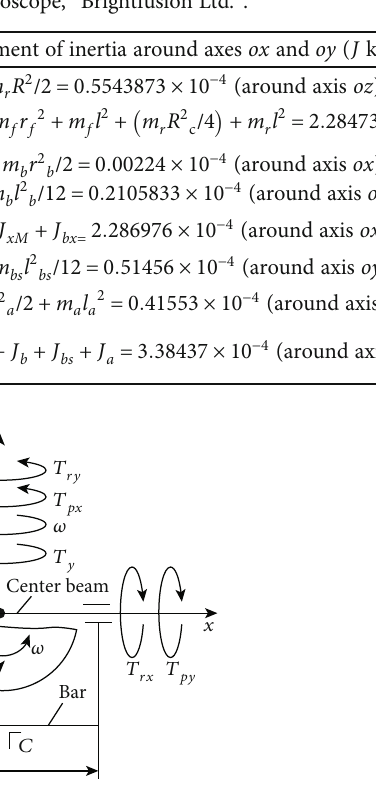
acts in the clockwise direction around axis oy . y